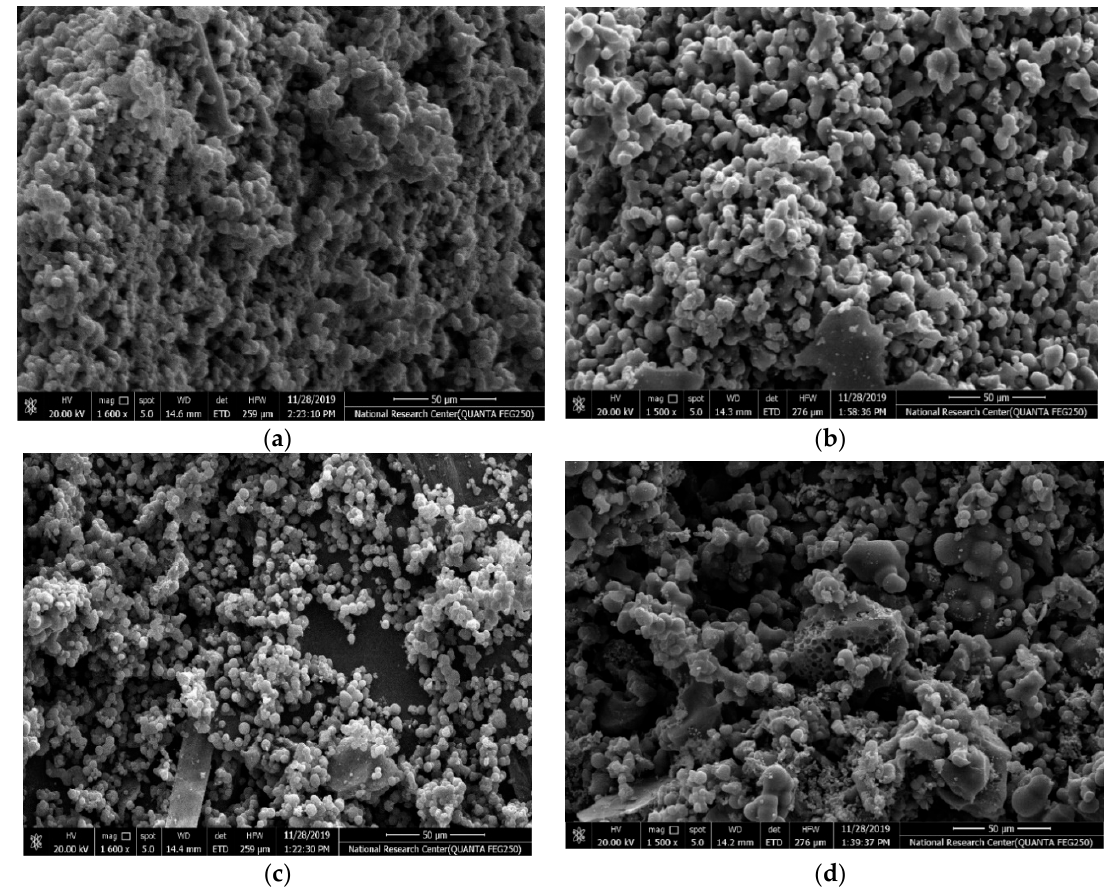
Figure 3. SEM images of samples ( a ) CX, ( b ) Ag-CX, ( c ) NiCo1/Ag-CX, and ( d ) NiCo5/Ag-CX.